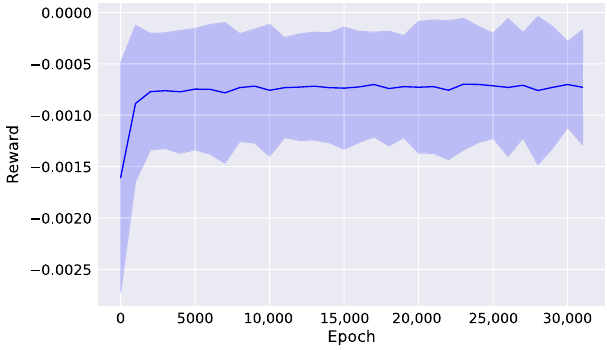
FIG. 11. The training process of the policy. Since the training is stochastic, we repeat it 500 times to get sufficient statistical evidence. The opaque graph shows the mean of all repetitions and the standard deviation is plotted semitransparent. The achieved reward improves only slightly after 20,000